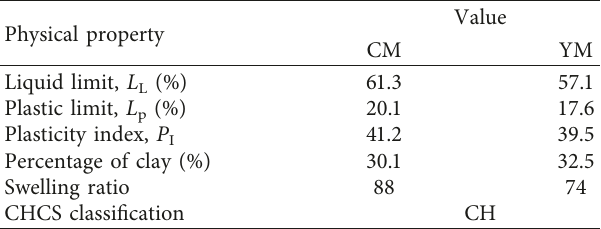
Table 1: Physical properties of tested